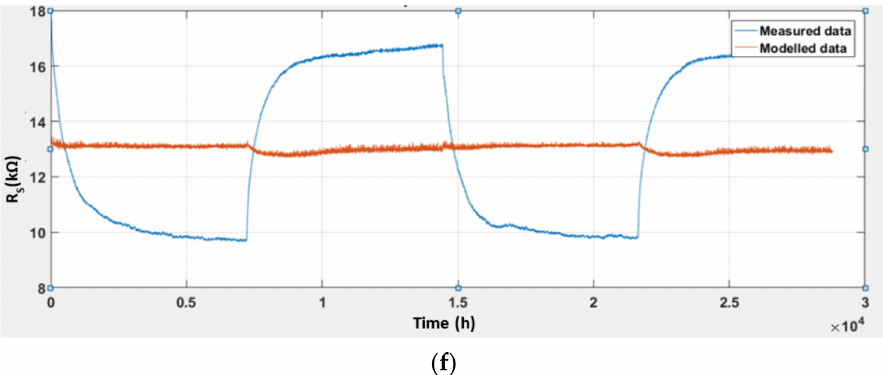
Figure 16. Temperature and humidity controlled using air conditioner: ( a ) Temperature (LM35); ( b ) humidity (HIH-5030); as well as measured and modelled sensor responses inside closed room using ( c ) MiCS-5524V2; ( d ) GM-402BV2; ( e ) GM-502BV2; and ( f )